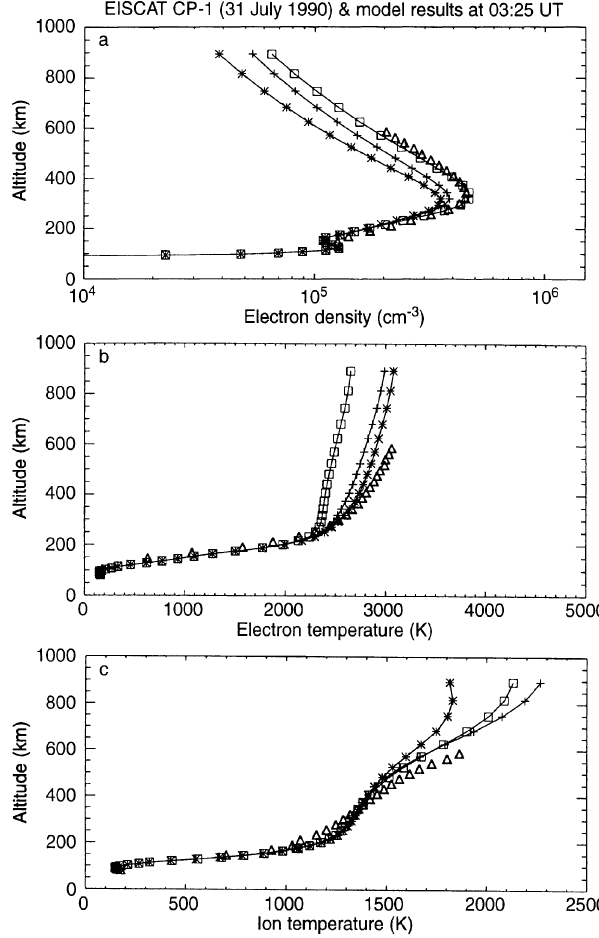
Fig. 2.a Electron density, b electron- and c ion-temperature profiles above the EISCAT station for 0325 UT on 31 July 1990; 1-h median values of the measured N (cid:101) and „ (cid:101) profiles around the time indicated are shown by triangles and are compared with different model results, here, illustrating the effect of N * (cid:50) : without including these reactions ( curves with crosses ), assuming „ (cid:118) " 1.25 „ (cid:110) ( asterisks ) and „ " 1.5 „ (cid:118) (cid:110) ( squares )